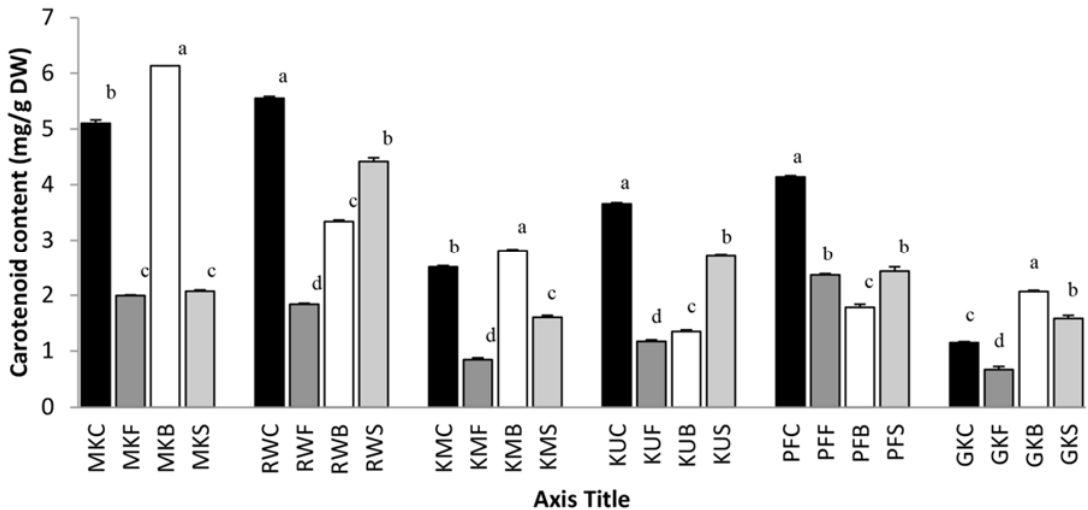
Figure 3. Total carotenoid content of raw and cooked extracts of some green leafy vegetables. Values represent the means of triplicate readings. MK, O. zeylanica ; RW, C. auriculata ; KM, S. grandiflora ; KU, G. lactiferum ; PF, P. edulis ; GK, C. asiatica . C—fresh leaves; F—fried; B—boiled; S—steamed. Data are means ± standard deviations of three replicate determinations. Columns with different letters for each vegetable are significantly different ( p < 0.05).